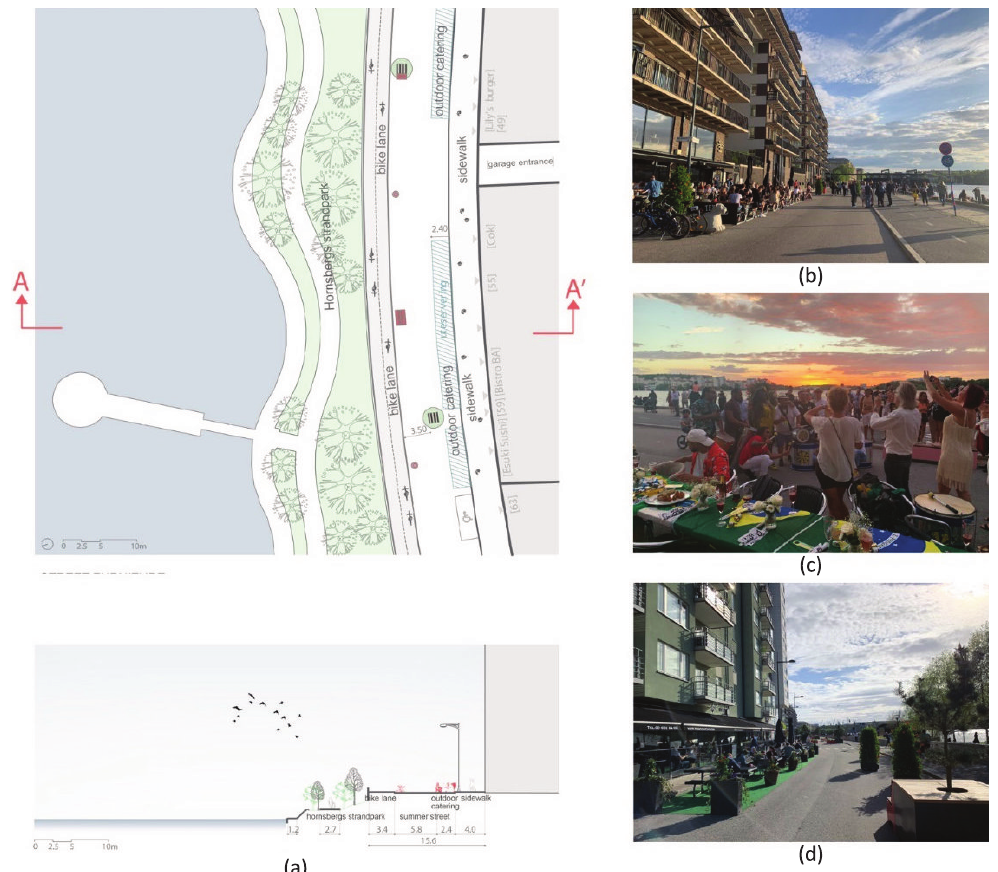
Figure 3. The outdoor catering service in the summer street HBS: (a) Street section A, (b), (c), and (d) examples of the outdoor catering space in the